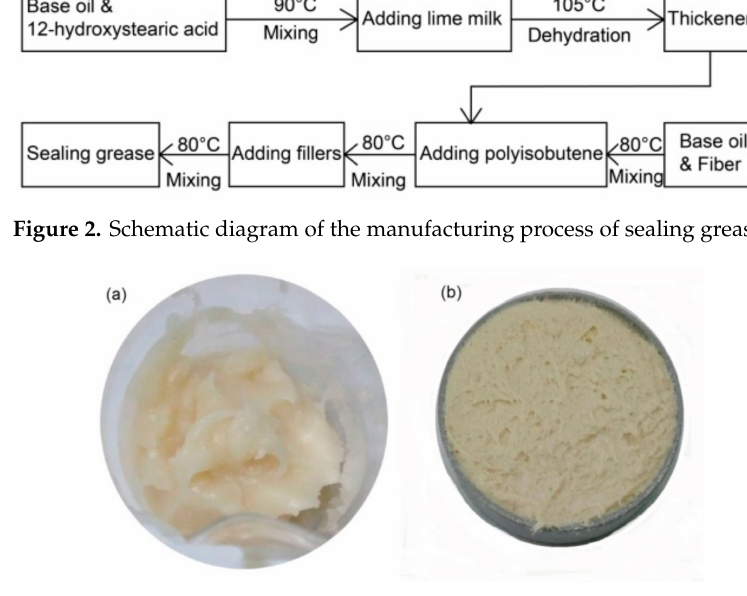
Figure 3. Samples preparation: ( a ) mixture of base oil and thickener; ( b ) sealing